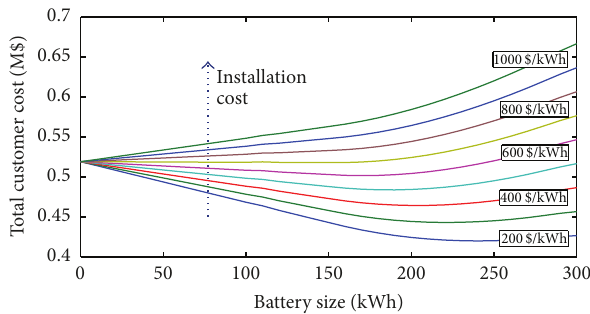
Figure 2: Total customer cost with 𝛼 = 5 %, 𝛽 = 5 %, 𝜂 = 98 %, for 5% annual load variations and for different and 𝜂 dch installation costs (residential load).